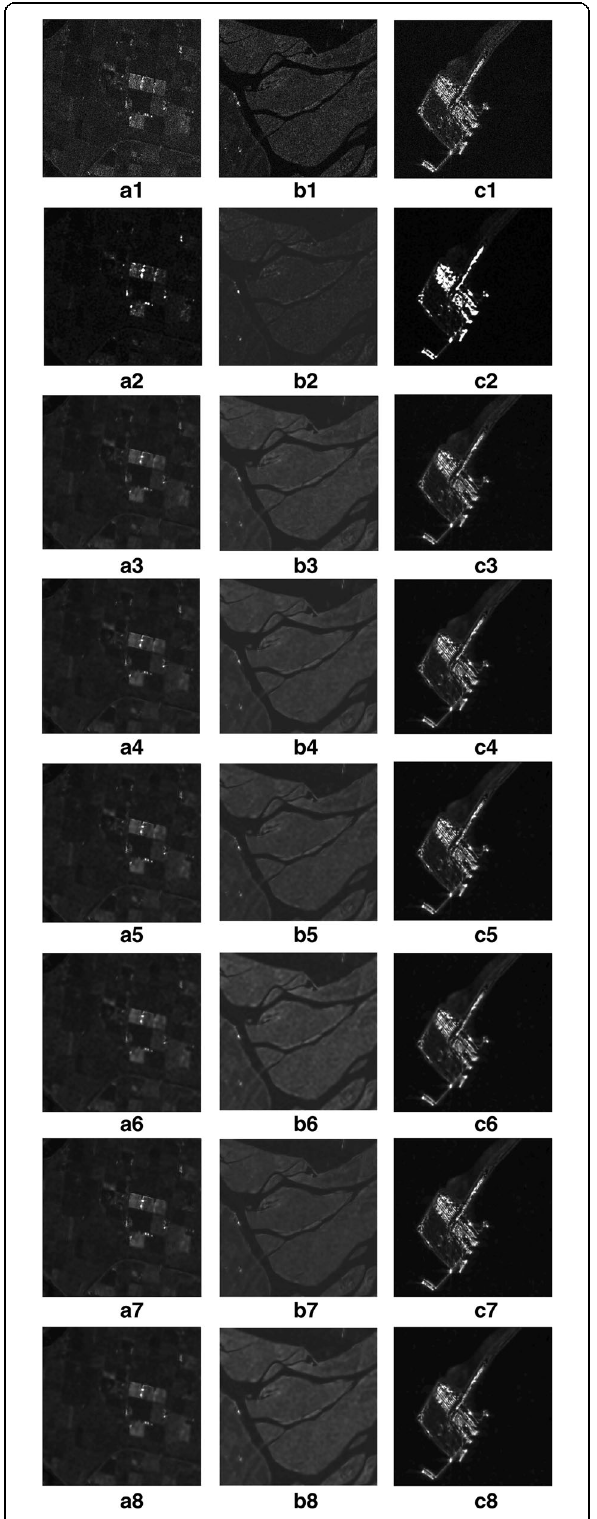
Fig. 10 Real SAR images called Farmland, Peninsula, and Shipping Terminal are shown on the first row, the results for High-TV [15], G Γ D ‐ NSST [13], NIG ‐ NSST [13], our proposed methods, BI-NSST(1), WBI-NSST(1), BI-NSST(2), and WBI-NSST(2) are shown in order from rows 2 to